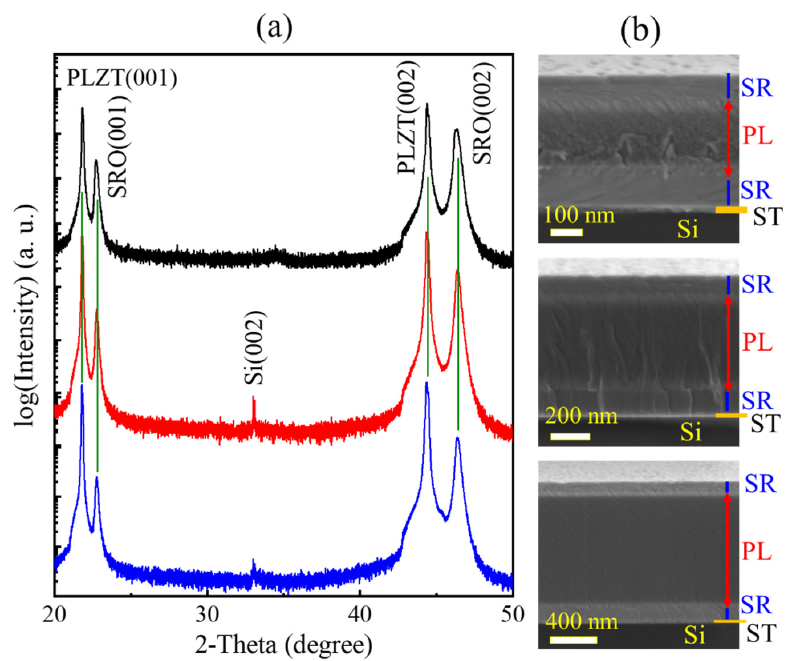
Figure 1. ( a ) XRD theta-2theta patterns and ( b ) corresponding cross-section SEM images of PLZT films.